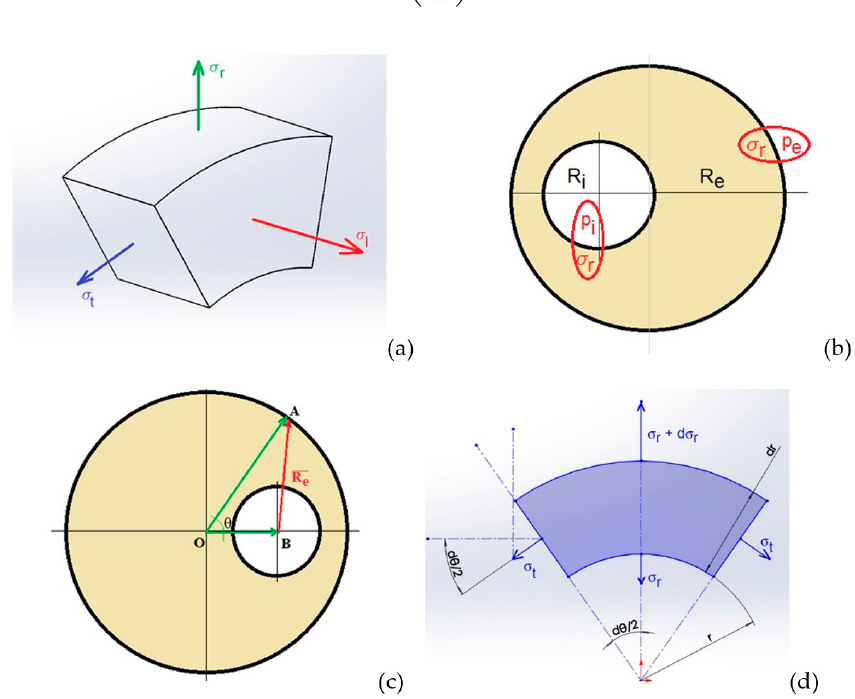
→ → → R e = OA − OB ( c ); illustration of